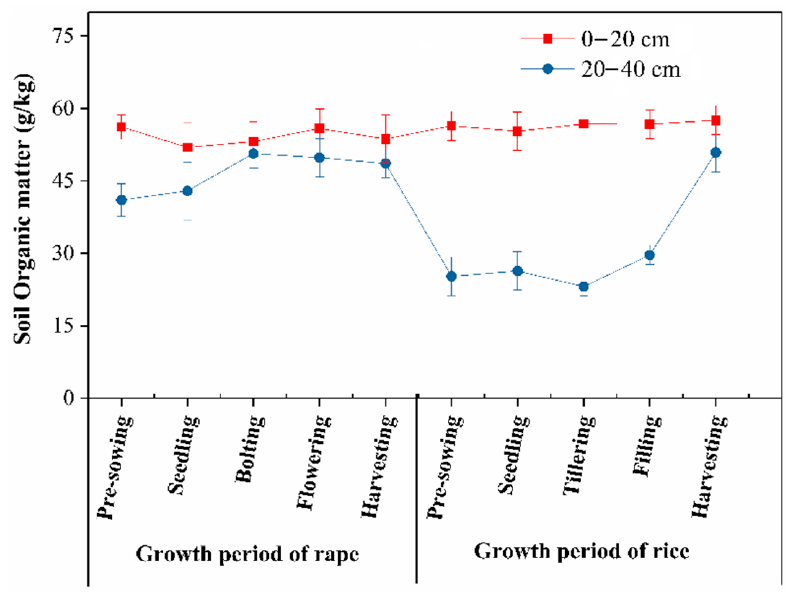
Figure 3. Changes of soil organic matter during rice–rape rotation.